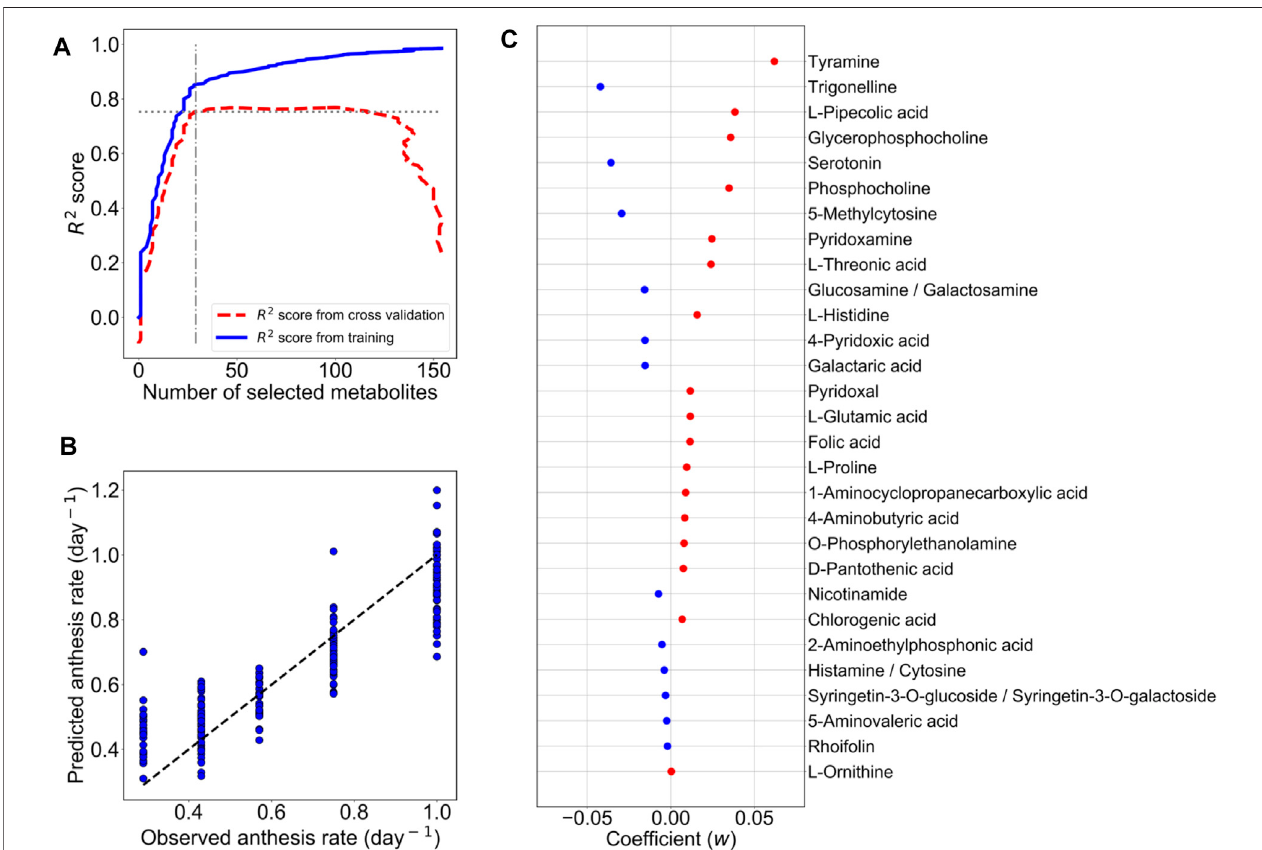
FIGURE2| LASSOmodelwithten-foldcross-validationforthepredictionoftheanthesisrateinTK01.ForLASSOregressionanalysis,themetabolicpro fi lesof161 metabolitesin192leafsampleswereemployed. (A) Thenumbersofmetabolitesusedforpredictorvariablesversus R 2 value.Theelbowpointsuggeststheoptimumset of metabolites for the prediction model. (B) Comparison of anthesis rates between observed and predicted values. Predicted values were obtained from the M-model with29selectedmetabolites.Thedottedlinerepresentstheagreementbetweentheobservedandpredictedvalues. (C) Coef fi cients( w )of29metabolitesselected by the M-model. Red dots are positive coef fi cients, while blue dots are negative coef fi cients.